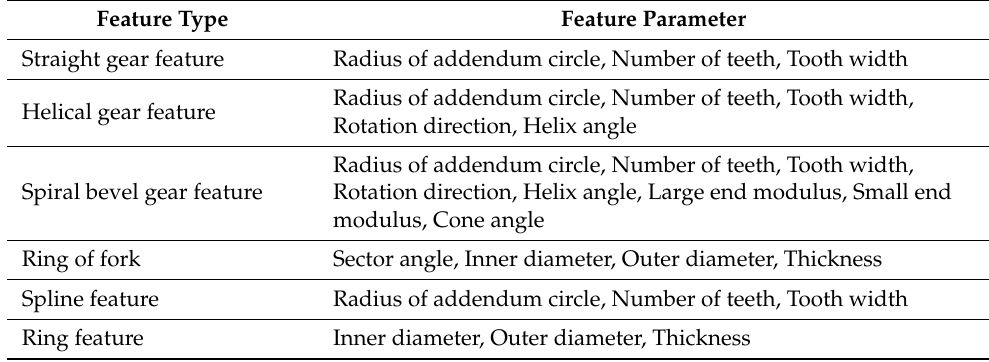
Table 2. The combination relationship between part features and feature